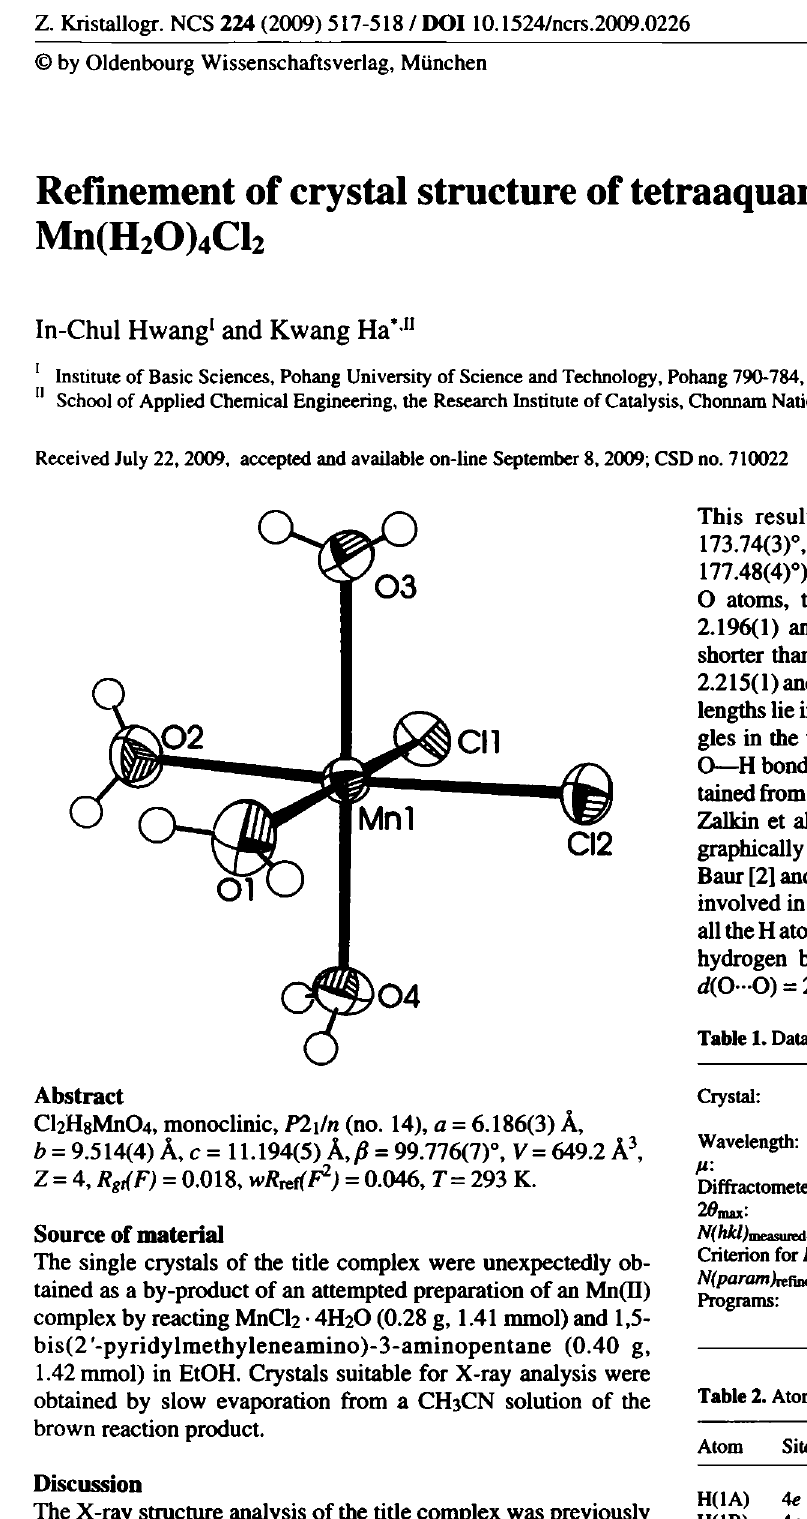
Table 2. Atomic coordinates and displacement parameters (in Â 2